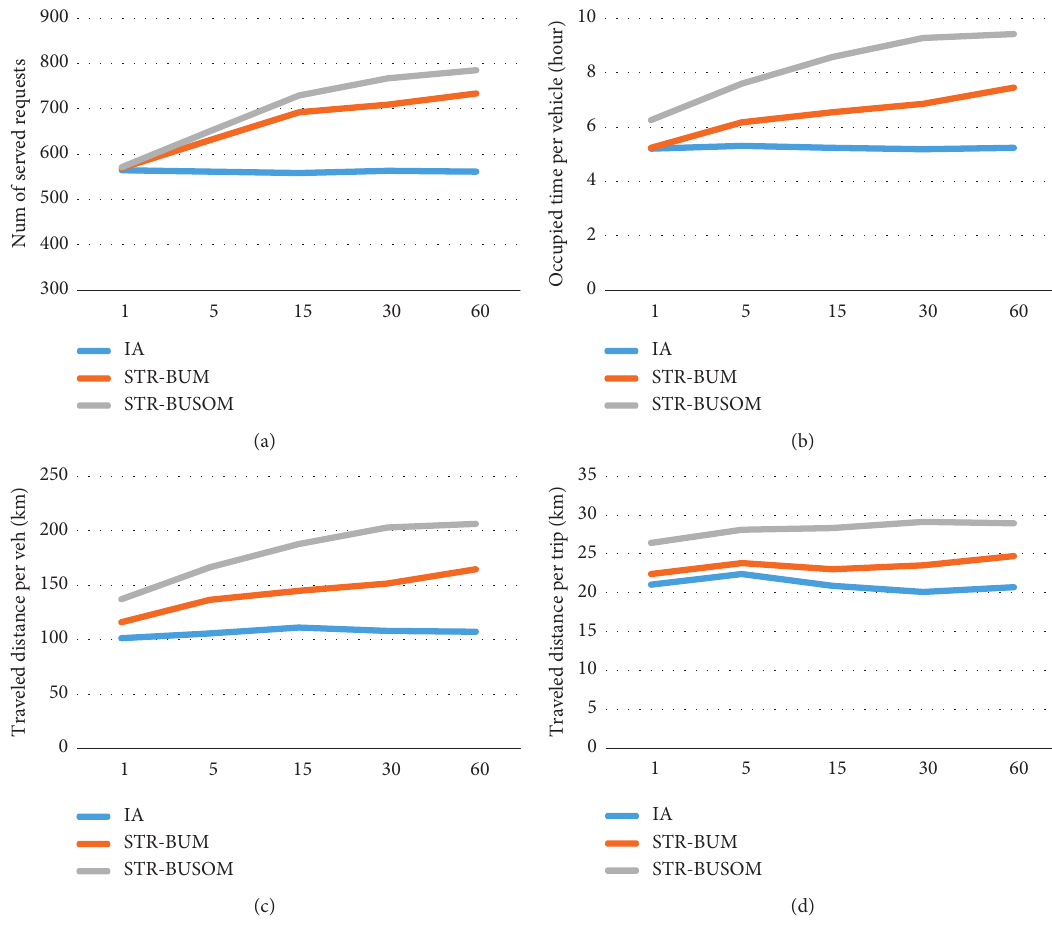
Figure 12: System potential if all users accept short-term reservation. (a) Number of served requests. (b) Average occupied time per vehicle. (c) Average traveled distance per vehicle. (d) Average traveled distance per